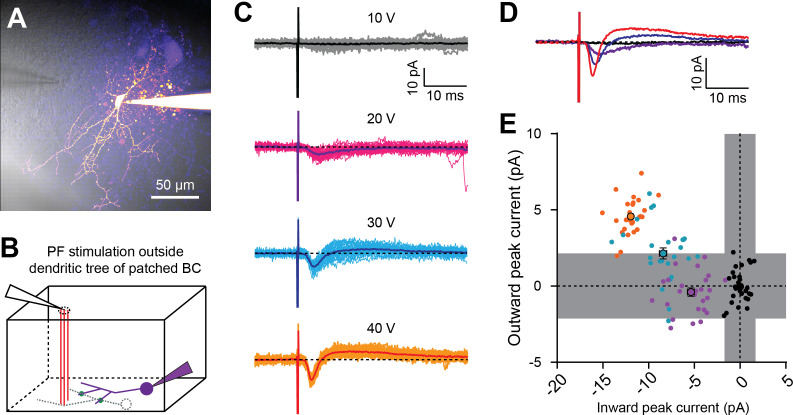
Evidence for subthreshold excitatory postsynaptic current (EPSC) transmission across electrical synapses.(A) 2PLSM image (maximal intensity projection) of a BC loaded with 20 µM Alexa-594. Dashed white lines indicate the position of the extracellular stimulation electrode on top of the slice (off-beam stimulation). (B) Schematic diagram of a parasagittal slice indicating off-beam stimulation of parallel fibers (PFs - red lines) synapsing onto the dendritic tree of an unpatched neighboring MLI (dashed gray lines), which forms putative electrical synapse(s) (green dots) with the patched BC (purple). (C) Postsynaptic current responses recorded in the patched cell in response to a single 50 µs extracellular voltage pulse delivered off-beam and at different intensities. Dark lines represent averages of 15–30 single trials. (D) Superimposition of average responses, shown for visual comparison of the differences in mean peak amplitude of inward and outward currents. Note the responses recorded at 20 V of stimulation intensity, which do not display outward currents, but only inward currents. (E) Summary plot of peak amplitudes of inward and outward currents shown in C, with corresponding averages +/- SEM represented by larger dots. Gray regions represent 2*SD of baseline values, averaged over all traces. See also Figure 3—figure supplement 1—source data 1.Figure 3—figure supplement 1—source data 1.Evidence for subthreshold excitatory postsynaptic currents (EPSC) transmission across electrical synapses.